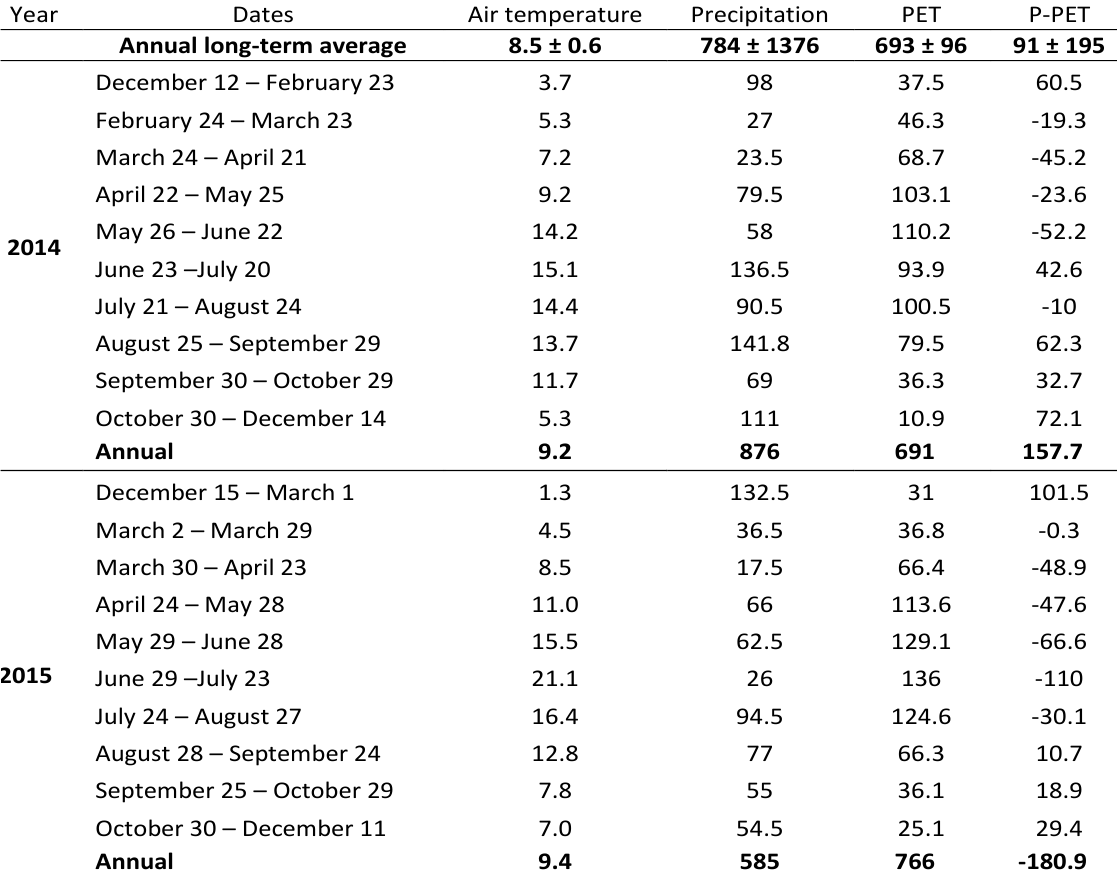
Table 1 . Air temperature (°C), precipitation (P, mm), potential evapotranspiration (PET) and climatic water balance: cumulated (P – PET, mm) and calculated for the 28 y period 1986-2013, mean values ± SD) and measured for the 10 dates in 2014 and 2015 corresponding to measurements of root growth and averaged (temperature) or summed (P, PET, P – PET) at annual